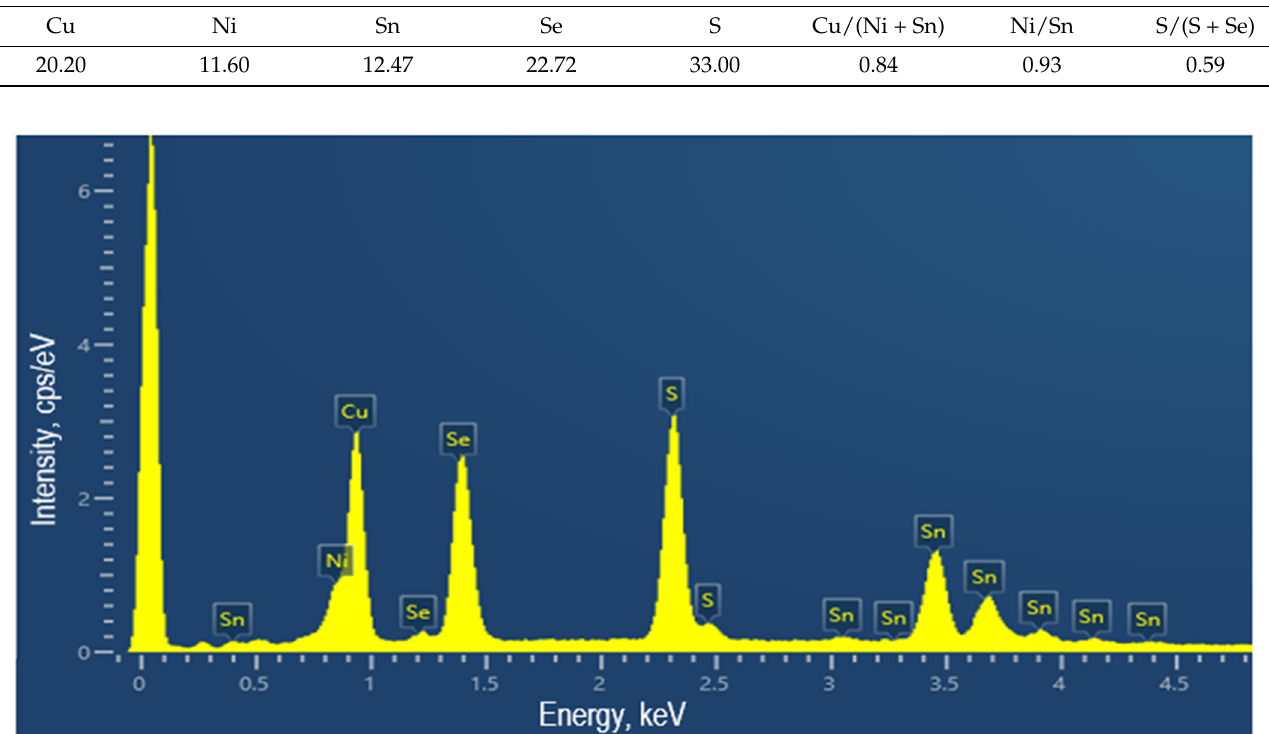
Figure 3. A typical EDX spectrum CNTSSe thin films on a glass/Mo substrate.